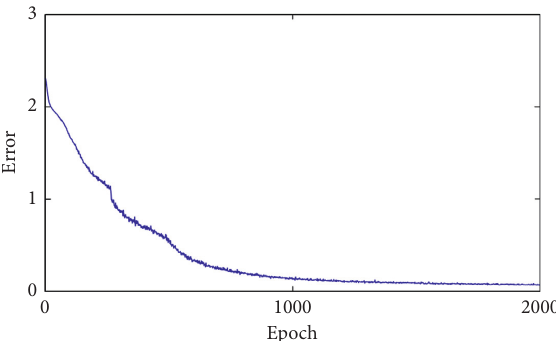
Figure 5: The training loss for the domain adaptation task N1 ⟶ N2. Table 3: Experimental result of CWRU.